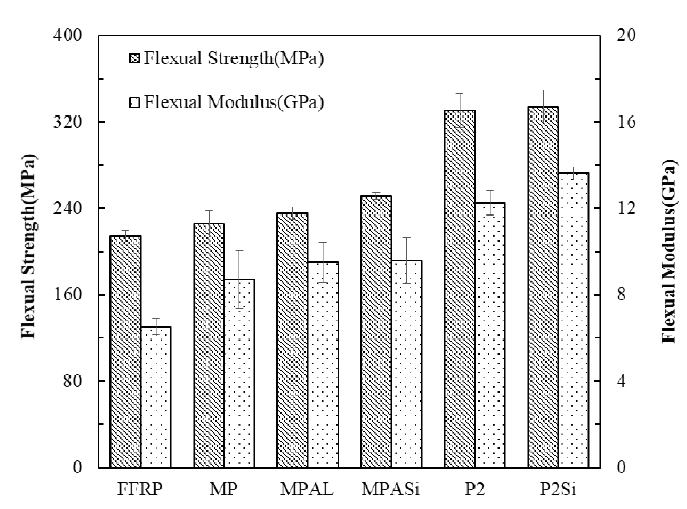
Figure 12. Flexural strength and modulus of FFRP and five types of surface-treated FFMLs composites.